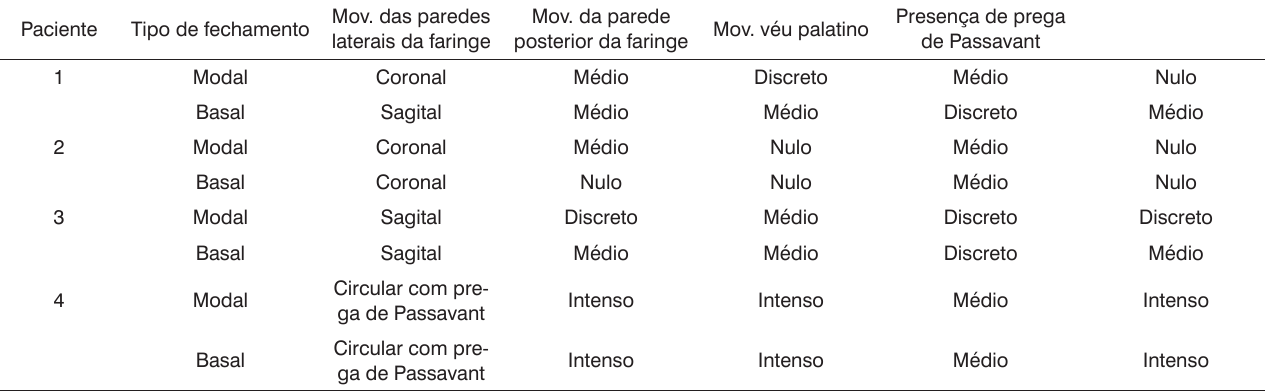
Tabela 1. Resultados da análise das imagens do EVF, conforme tipo de fechamento velofaríngeo e movimentação das estruturas, antes e